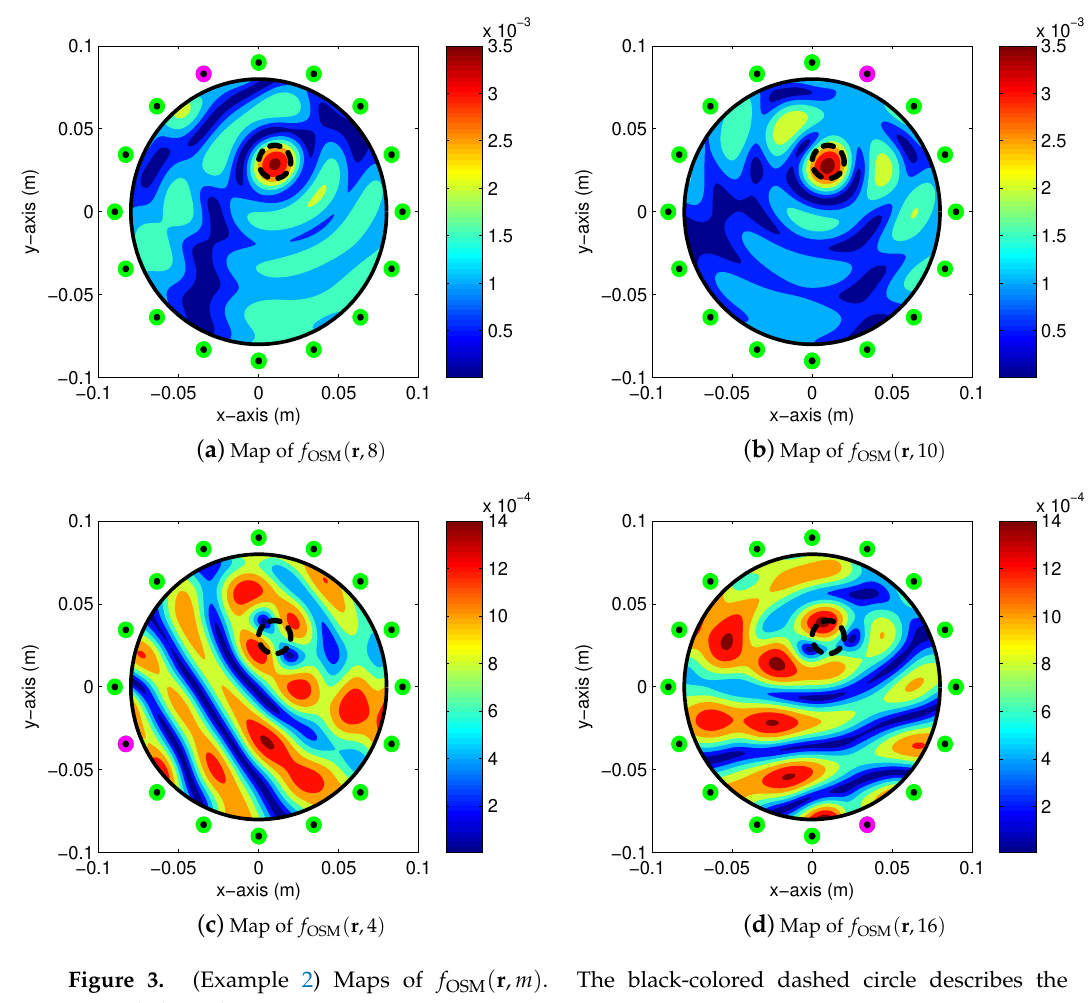
Figure 3. (Example 2) Maps of f OSM ( r , m ) . The black-colored dashed circle describes the anomaly boundary.